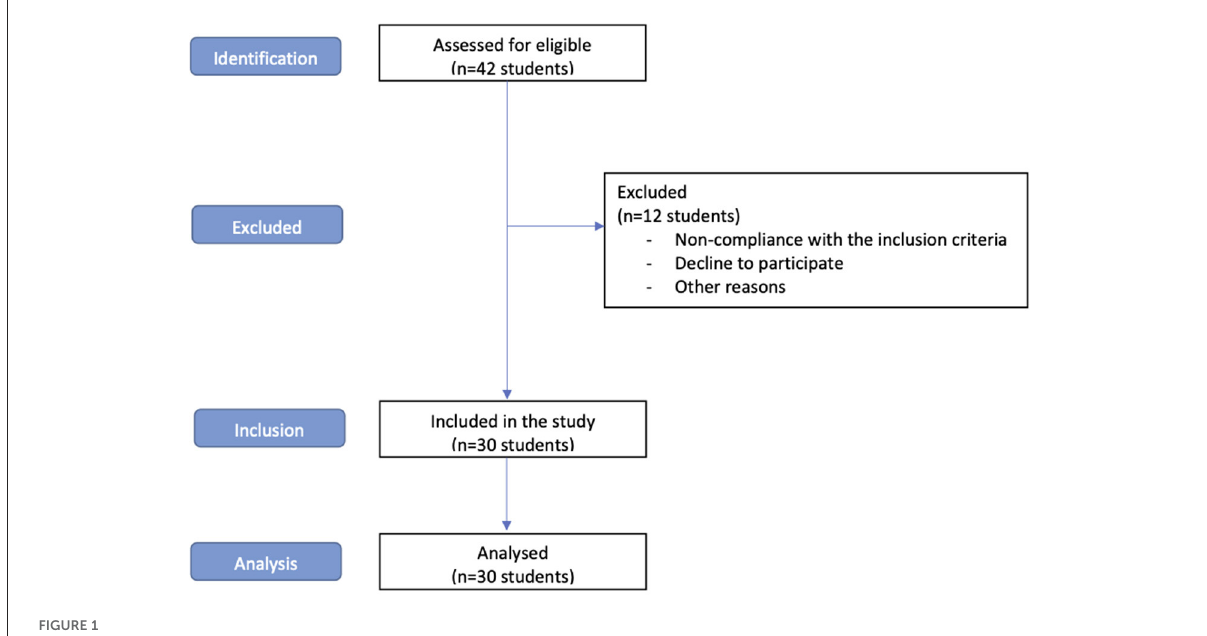
FIGURE1 STROBE flow